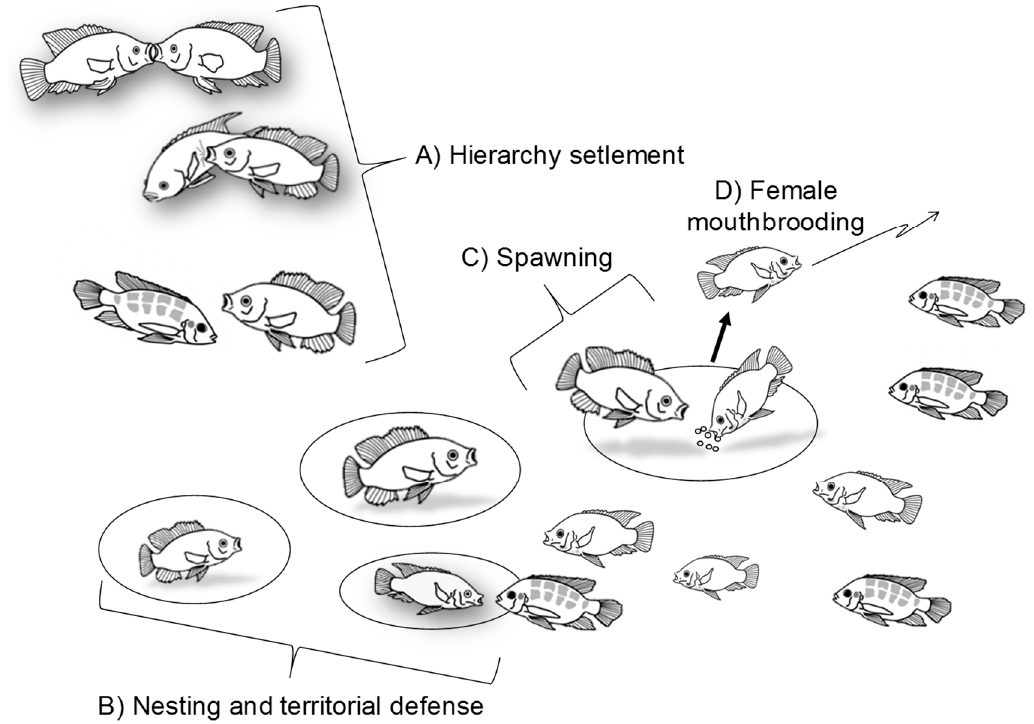
Figure 1. Nile tilapia’s social behavior. Males fight (A) and a dominant and subordinate rank (clear and gray fish, respectively) emerge; the dominant male starts to defend a territory, wherein it digs a circular nest (B). The mating system is a lek polygyny; then several males dig nests surrounding dominants (B). Fish continue defending territory and attracting females (C). After spawning, the female leaves the arena and starts mouthbrooding until fryers arise (D). Some males do not get territory and stay around the arena challenging territorial males (some act as sneakers). Females (the smallest fish in the drawing) visit the arena and mate with territorial males.